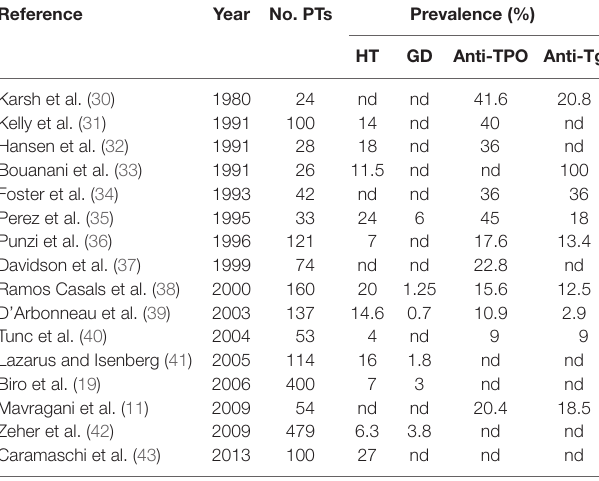
TAble 1 | Prevalence of AITD in Sjögren’s